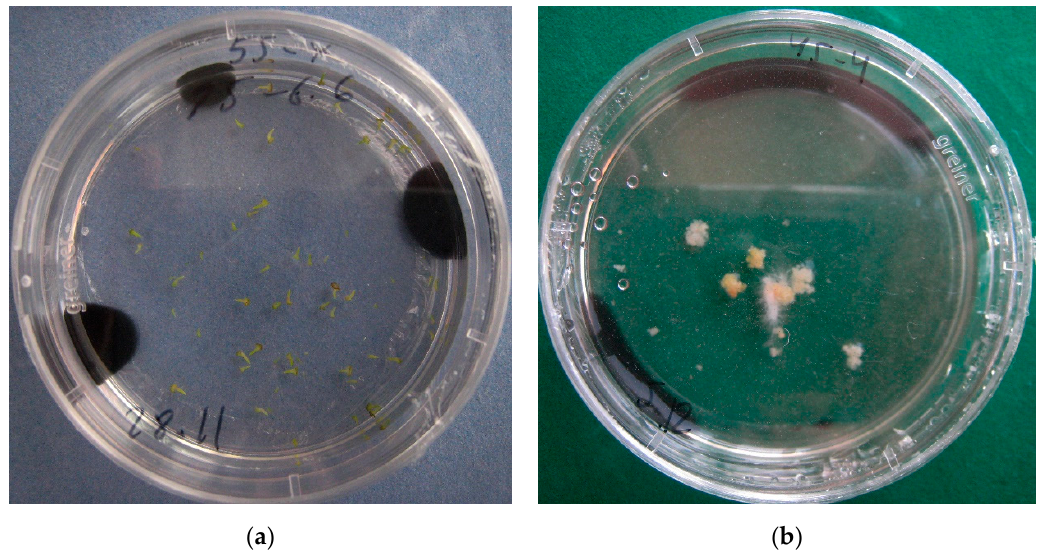
Figure 1. Types of turnip microspores development in the in vitro culture: ( a ) embryos of the ‘Roots’ variety, medium pH 6.6 and AC presence; ( b ) calluses and embryos of variety ‘York Globe’, medium pH 6.6 and AC presence.